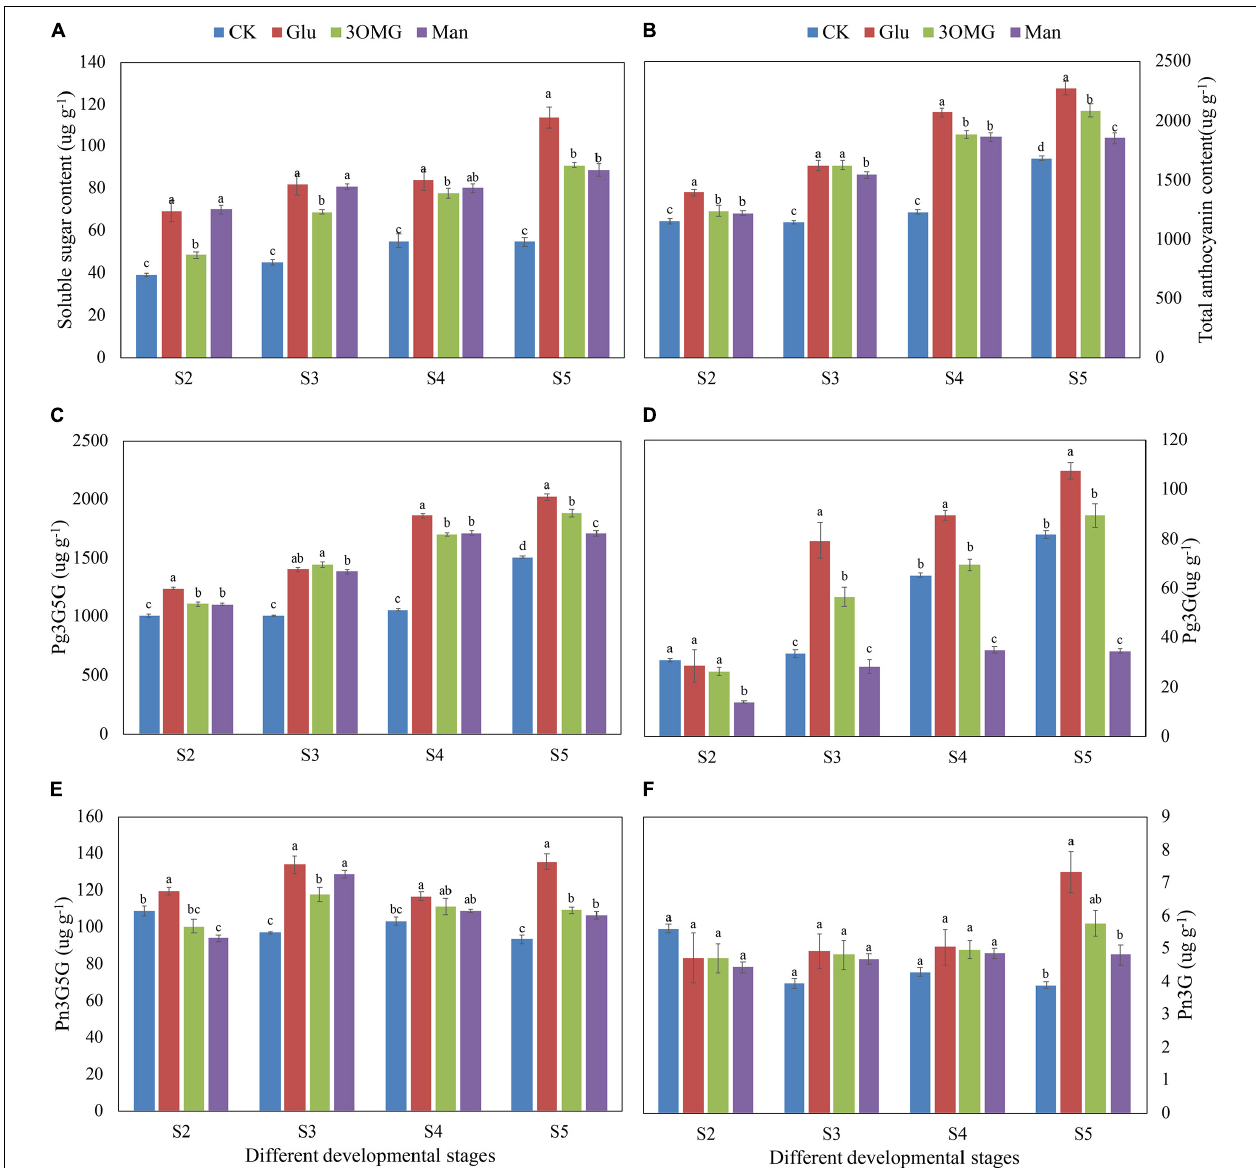
FIGURE 3 | The soluble sugar contents in petals of P. suffruticosa ‘Tai Yang’ cut flowers under four treatments (A) . The total anthocyanin contents in petals of P. suffruticosa ‘Tai Yang’ cut flowers under four treatments (B) . The contents of four anthocyanin compositions in the petals of P. suffruticosa ‘Tai Yang’ cut flowers under four treatments (C–F) . (C) Pelargonidin-3,5-di-O-glucoside (Pg3G5G); (D) pelargonidin 3-O-glucoside (PG3G); (E) peonidin-3,5-di-O-glucoside (Pn3G5G); (F) peonidin-3-O-glucoside (Pn3G). There were four treatments including CK, Glu, 3OMG, and Man, respectively. CK was the control group that cut flowers treated with distilled water. Glu, 3OMG and Man were the cut flowers treated with glucose, 3-O-methylglucose and mannose at 333 mM, respectively. S2, pre-opening stage; S3, initial opening stage; S4, half opening stage; S5, full opening stage. Each value was expressed as the mean ± standard errors (SE) of triplicate replications. Different small letters indicated significant differences among treatments at the same developmental stage according to Duncan’s multiple range test at p < 0.05.